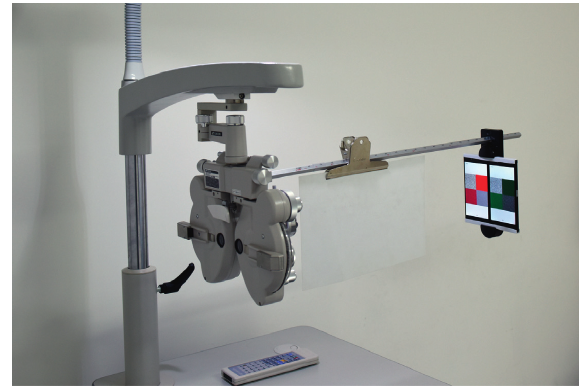
Figure 1: Photograph of the actual